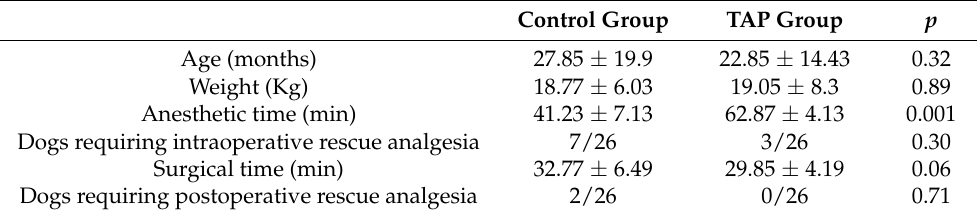
Table 1. Comparative results of population and perioperative parameters between dogs that under- went laparoscopic ovariectomy with or without TAP block. Data are shown as mean ± SD. Control Group TAP Group